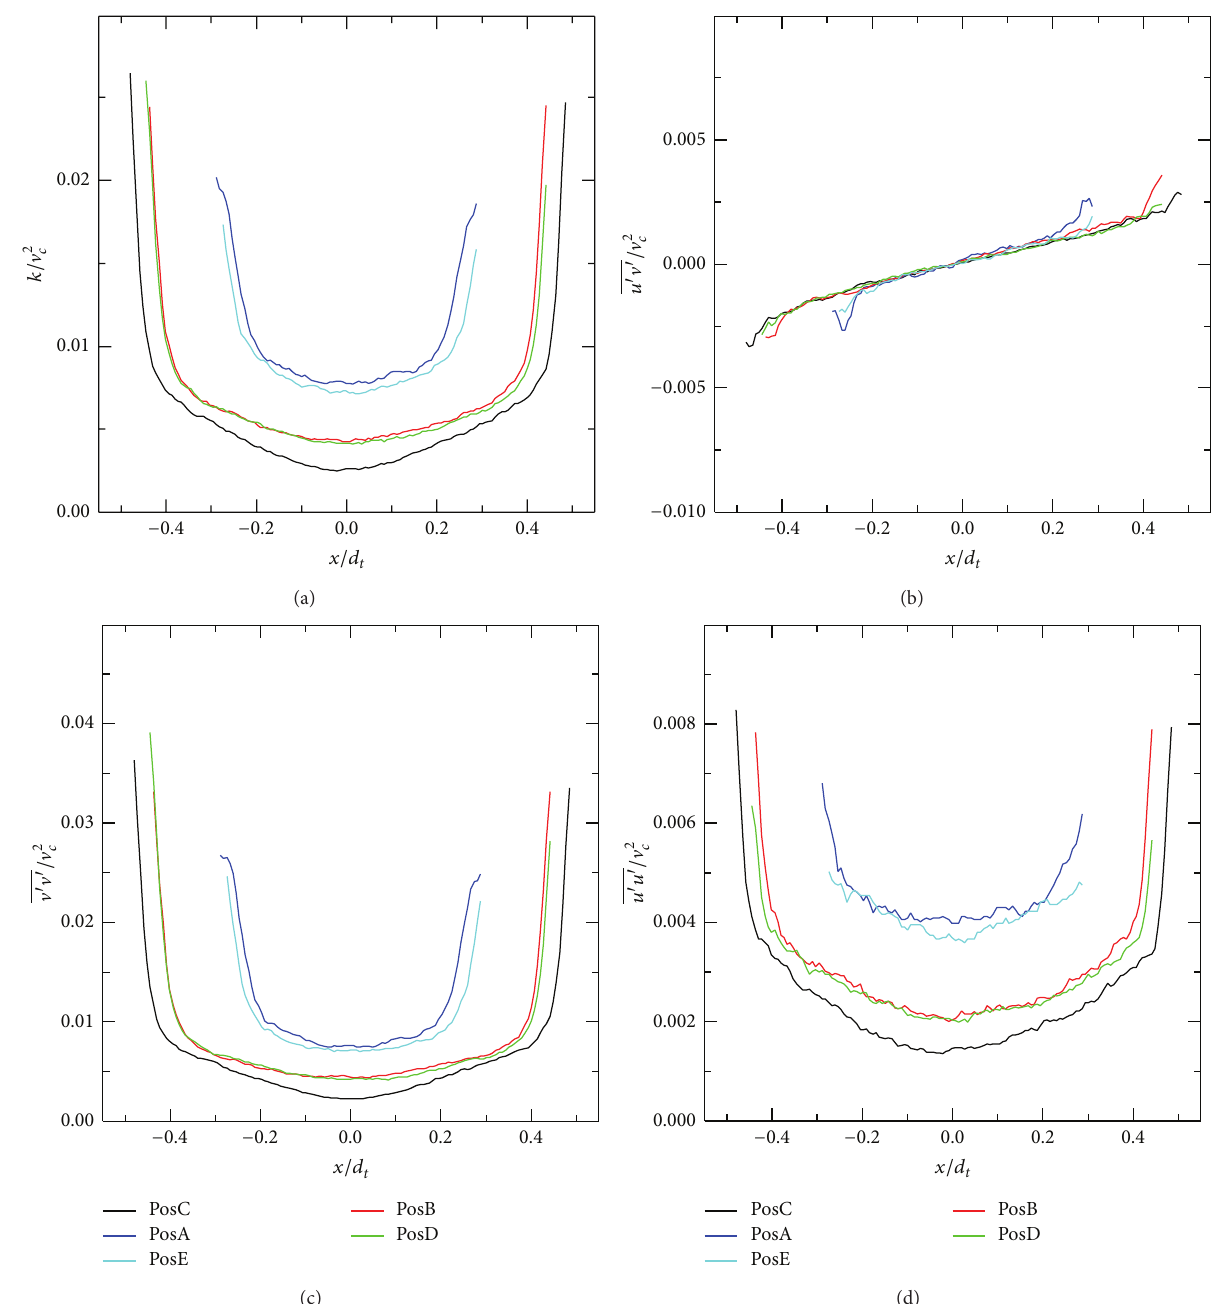
Figure 7: Normalized turbulent kinetic energy 𝑘 calculated with (11) (a) and Reynolds stresses 𝑢 󸀠 V 󸀠 , V 󸀠 V 󸀠 , and 𝑢 󸀠 𝑢 󸀠 ((b), (c), and (d)) for the measurement planes A–E (Figure 4) at 𝑦/𝑑 𝑡 = 0.097 above the injection pipe